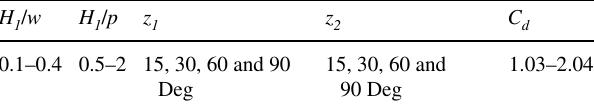
Table 2 The values of dimensionless